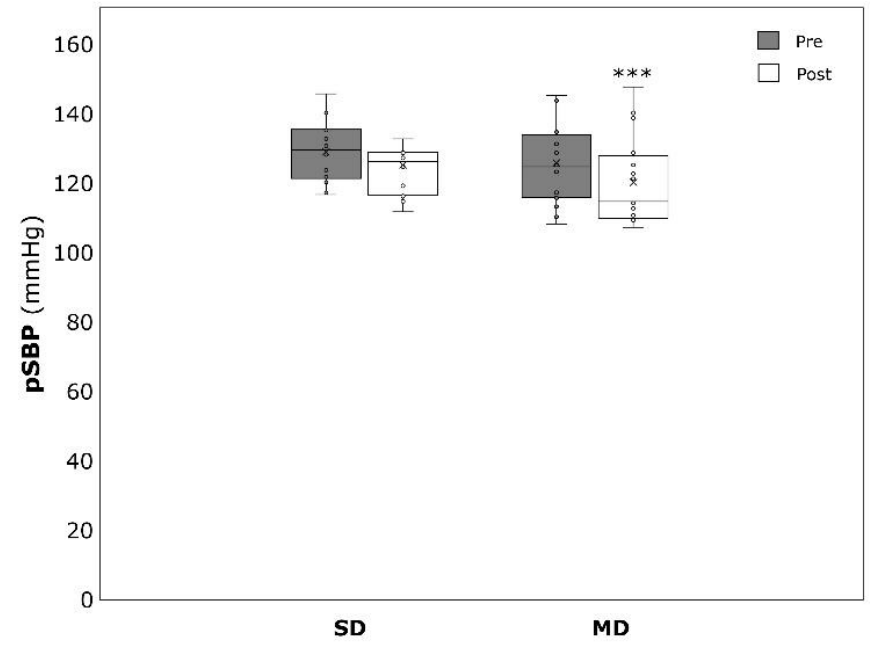
Figure 2. Peripheral systolic blood pressure (pSBP) before (pre) and after (post) the intervention period for severely depressed (SD) and mildly depressed (MD). *** p < 0.001 within-group differ- ence.